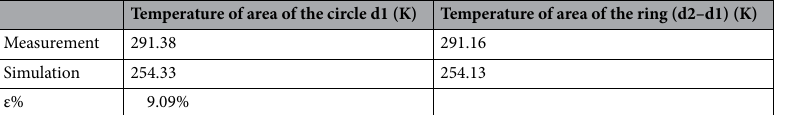
Table 6. Comparison of numerical and experimental